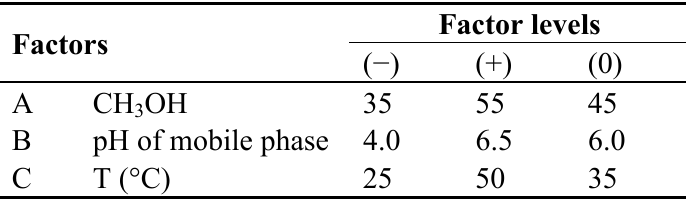
Table 3. Factors and